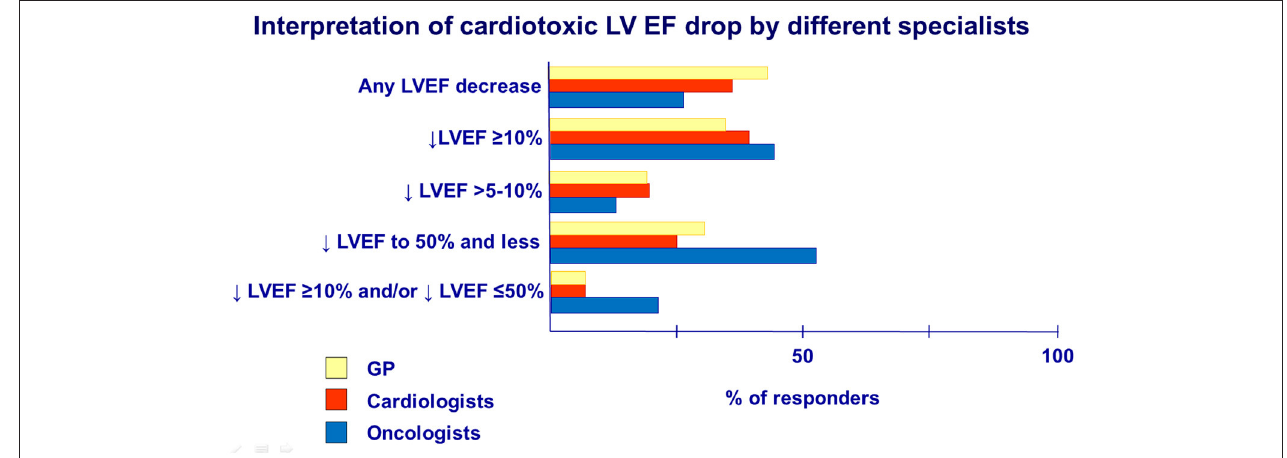
FIGURE 5 | Interpretation of cardiotoxic LV EF drop by different